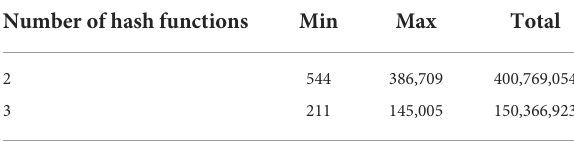
TABLE 1 Comparison on number of signatures in the change of number of hash functions when building index for set S2.